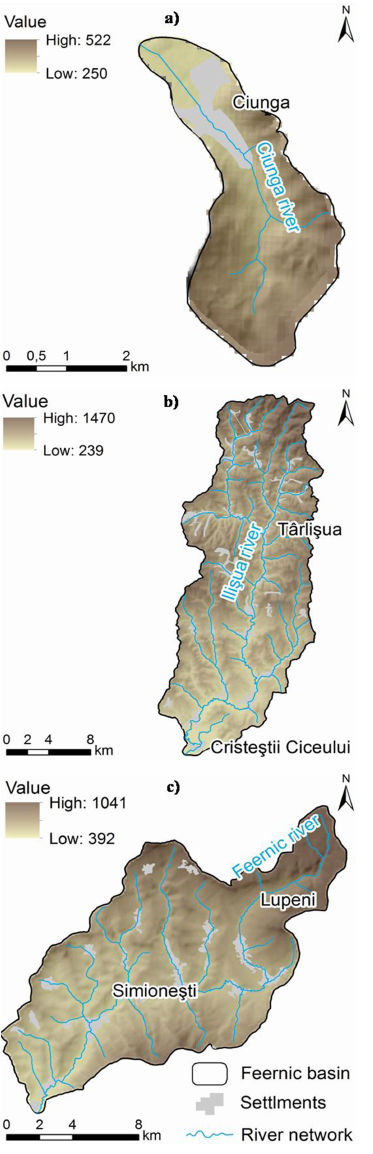
Fig. 4. The studied watershades: (a) Feernic Basin, (b) Ili¸sua Basin and (c) Ciunga Basin.